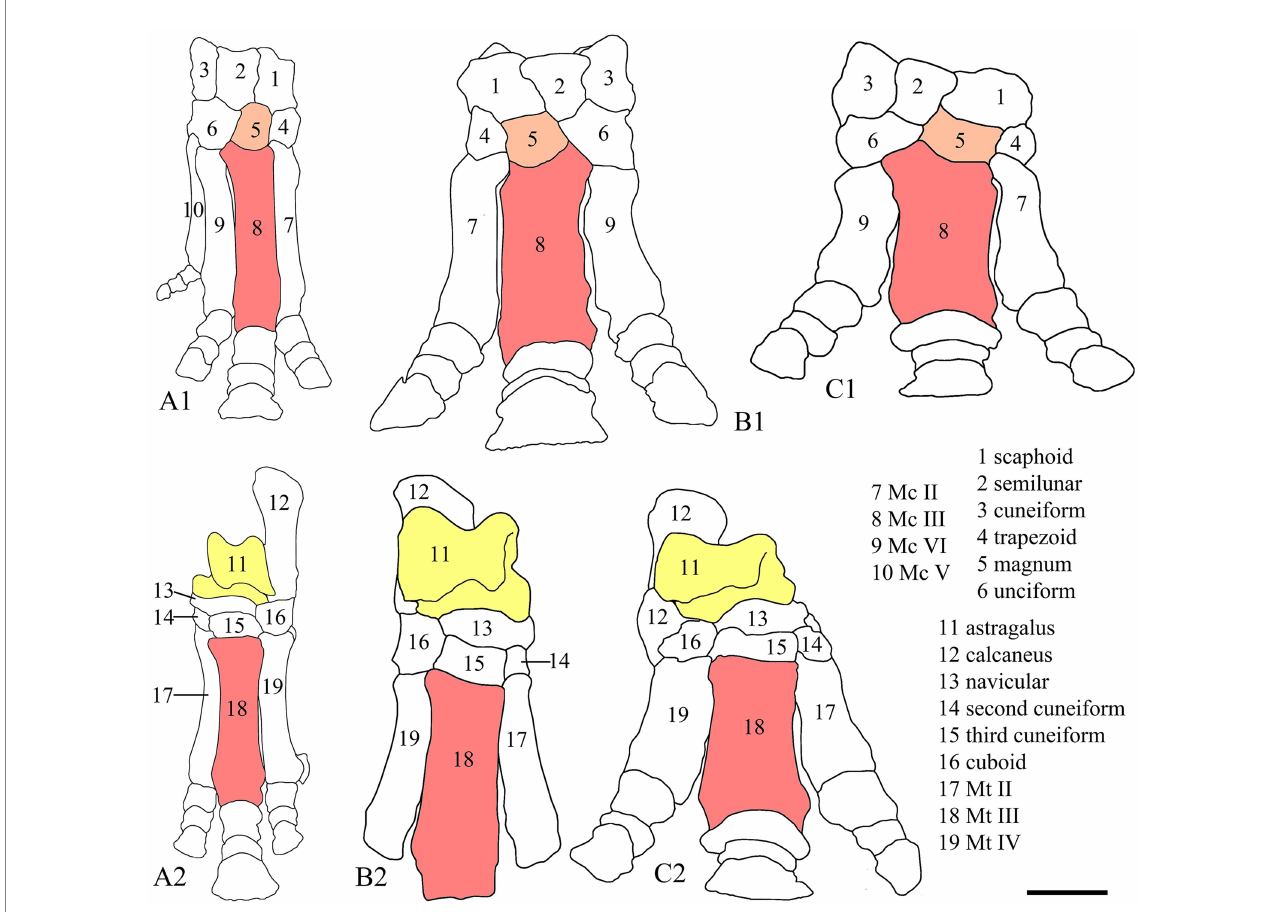
FIGURE 5 Drawings of distal limb bones of rhinocerotids. 1, fore-limb; 2, hind-limb. (A) Trigonias osborni , AMNH 9847, Scott (1941). (B) Aphelops megalodus , A1/A2 AMNH 9745/5293, based on a specimen by Matthew (1918). (C) Teleoceras fossiger , AMNH 2650, based on a specimen by Matthew (1918). The scale of the latter two are from measurements by Prothero (2005). Color areas mark magnum, Mc III, astragalus, and Mt III on different rhinoceroses. Scale bar = 50